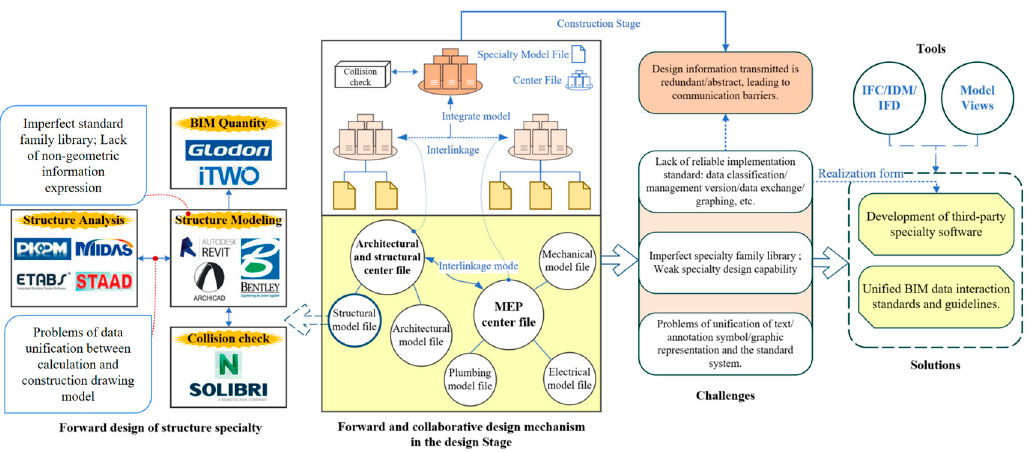
Figure 1. The status of BIM software application of forward design.